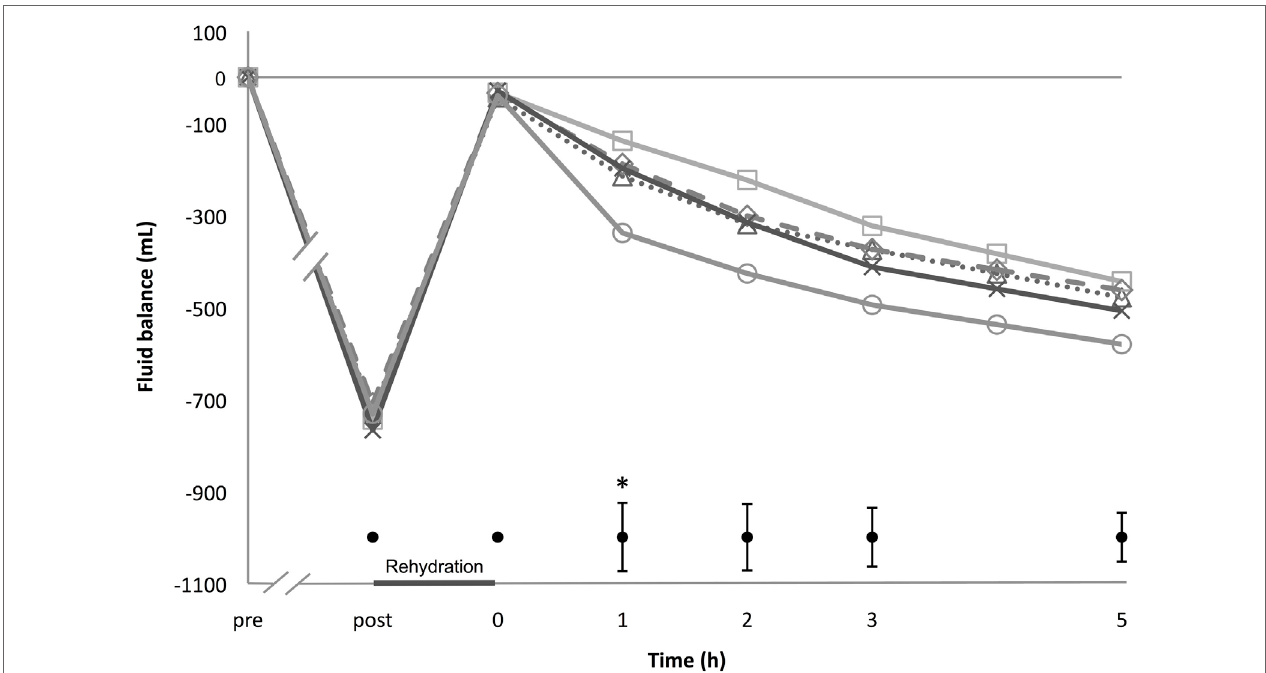
FigUre 2 | net fluid balance . Starting pre-exercise and ending 5 h after rehydration; Δ 0% beer; × 2% beer; ○ 5% beer; □ sports drink; ◊ water. At the bottom are ± 1 pooled SD bars per time point. * p < 0.05 between 5% beer and sports drink, 1 h in the post-rehydration